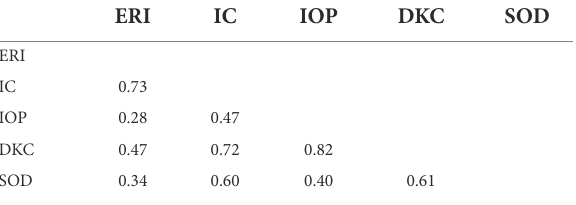
TABLE 4 Heterotrait-Monotrait test